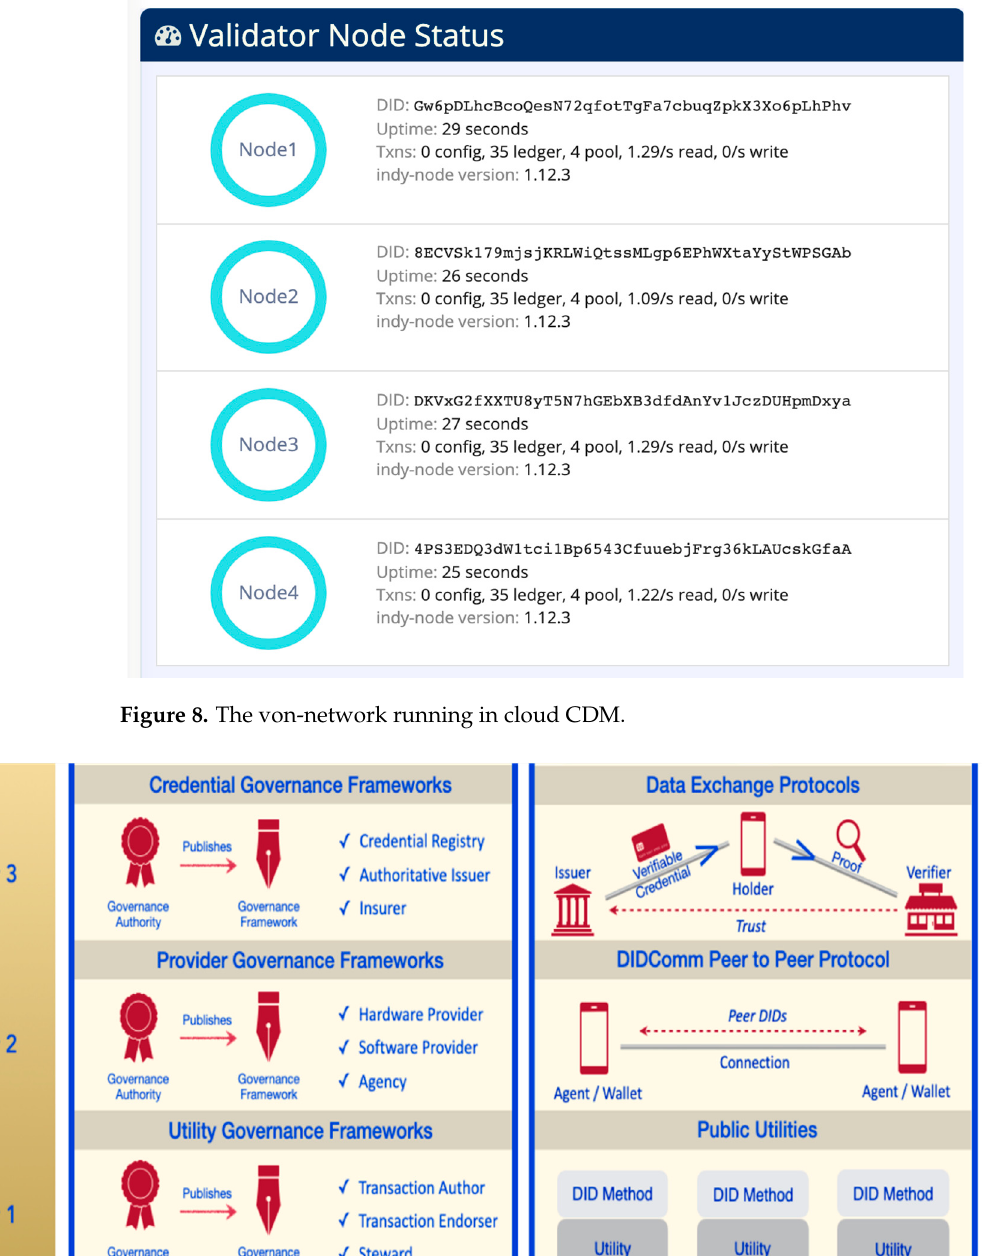
Figure 9. Trust over IP framework [36].